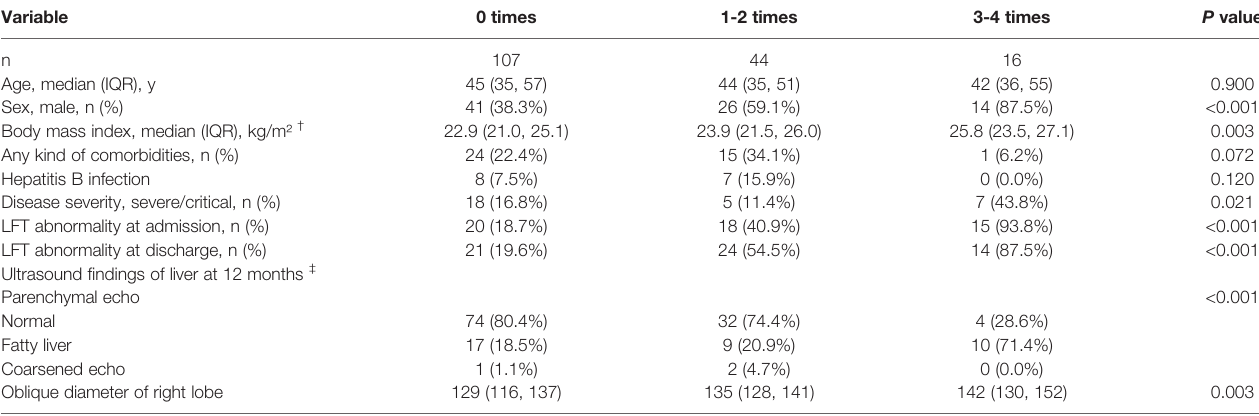
TABLE 3 | Comparison of Demographics, Comorbidities, Outcomes, Baseline Liver Biochemistry, and Ultrasound Results between Subgroups Strati fi ed by the Number of Liver Function Tests Abnormalities at 4 Follow-up Time Points. Variable 0